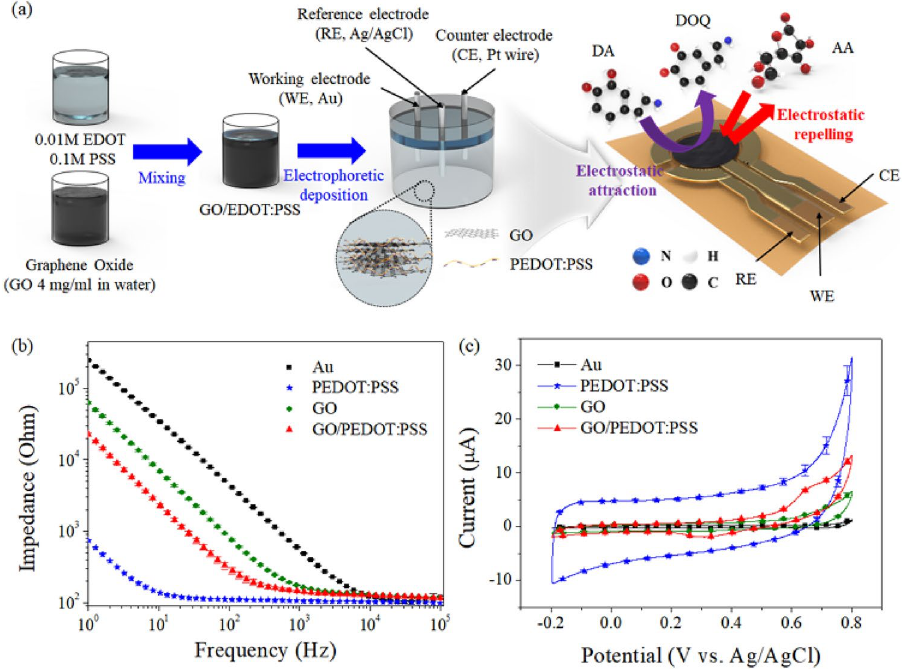
Figure 1. ( a ) Schematic drawing of the electropolymerization process of the GO/PEDOT:PSS composite on an Au working electrode and the configuration of the flexible sensor with the GO/PEDOT:PSS composite as a working electrode; ( b ) the comparison of the impedance and ( c ) cyclic voltammogram of Au, PEDOT:PSS, GO and GO/PEDOT:PSS composite in a 0.1 M PBS solution (pH 7.4). The scan rate was 100 mVs −1